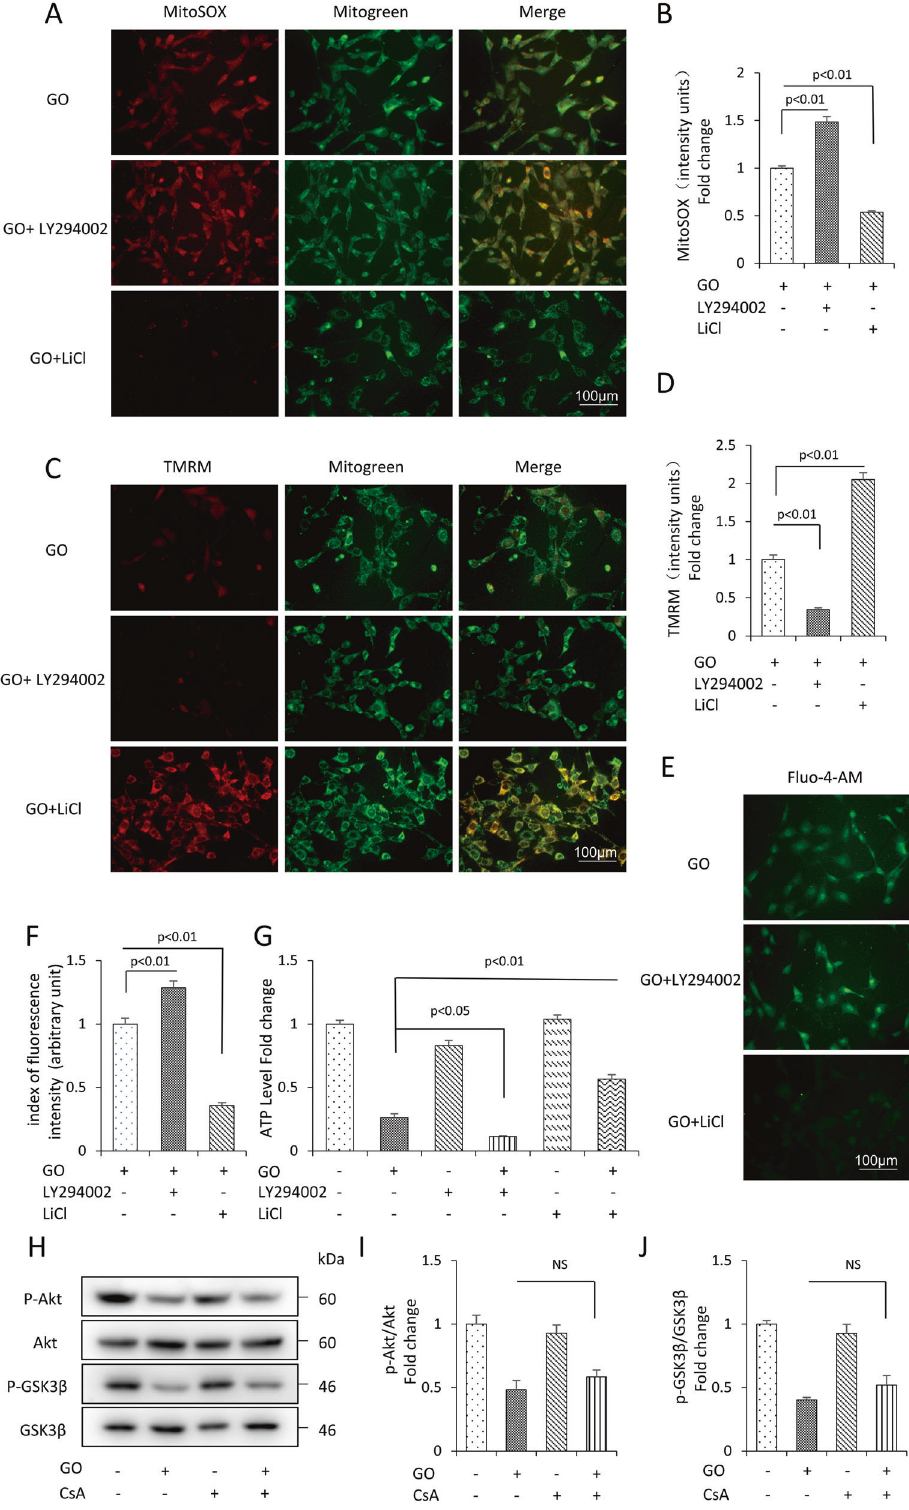
Fig. 6 Glucose oxidative acted through the Akt-GSK3 β pathway to induce mPTP opening in mDPC6T cells. MitoSOX staining ( A ) and quanti fi cation ( B ) in the indicated groups. TMRM staining ( C ) and quanti fi cation ( D ) in the indicated groups. Fluo-4-AM staining ( E ) and quanti fi cation ( F ) in the indicated groups. G ATP in the indicated groups. H – J Protein level of p-Akt and Akt, p-GSK3 β and GSK3 β treated with ( + ) or without ( − ) CsA in the presence ( + ) or absence ( − ) of glucose oxidase by Western blot and quanti fi cation analysis. The values are expressed as the means ± SD ( n =